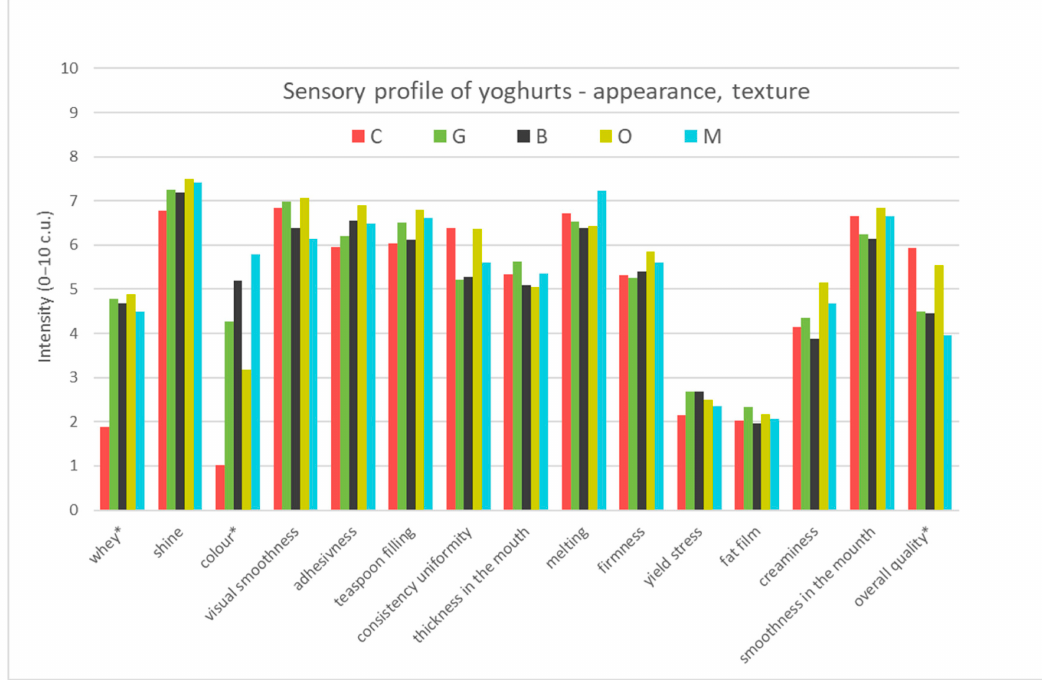
Figure 2. The sensory quality profile of yoghurt samples (taste and flavour) C—Control, G—Green tea, B—Black tea, O—Oolong tea, M—Lemon balm (t-taste, f-flavour), (*—di ff er significantly p ≤